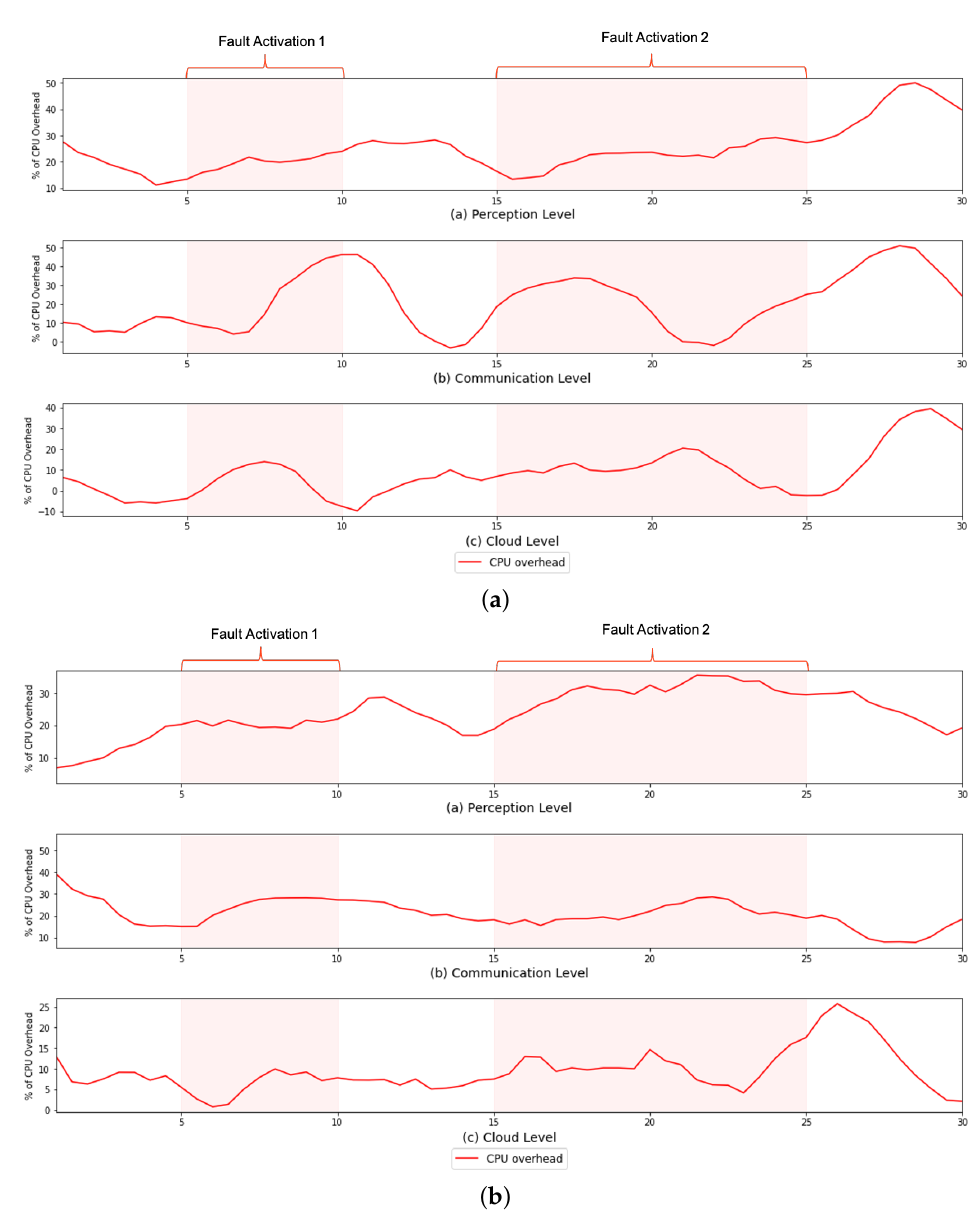
Figure 7. A comparison of the CPU overhead over time in each experimental scenario. ( a ) S#1—CPU overhead over time. ( b ) S#2—CPU overhead over